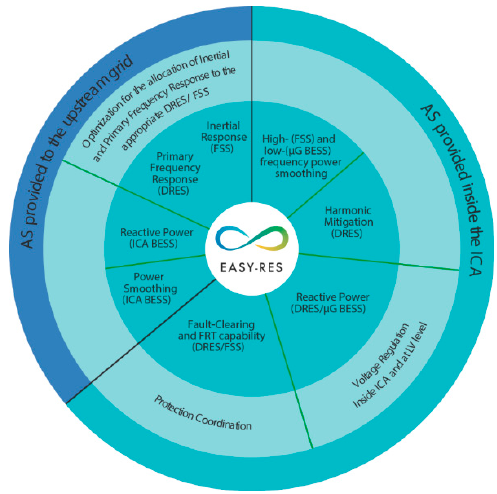
Figure 1. General representation of a distribution grid (ICA) .